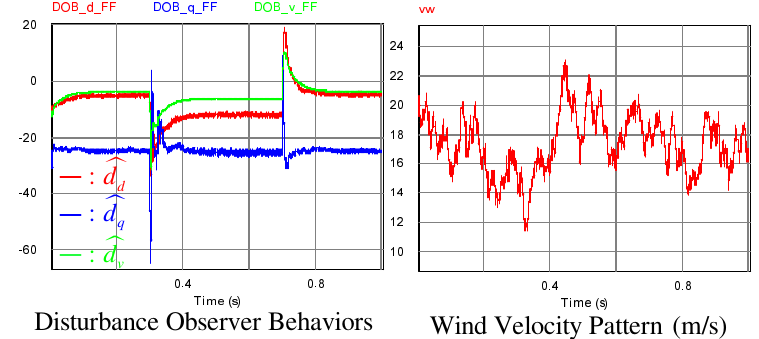
Figure 4. The estimated disturbance behaviors and the wind pattern based on the Weibull distribution. The second simulation compared the DC-link voltage regulation performances by applying the pulse resistive load from R L = 100 Ω to R L = 28.6 Ω at the 300 V operation mode. Figure 5 depicts the comparison results, which imply that the proposed method considerably reduces the over/under shoots caused by the load variations, compared to the classical FL method. The correponding PMSG output power behaviors are presented in Figure 6.